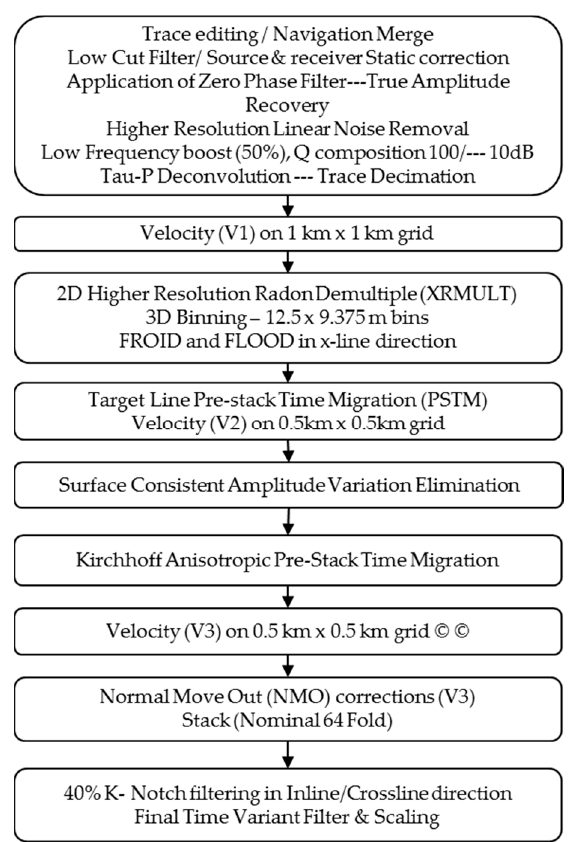
Figure 4. Processing flow chart (adapted from the PETRONAS report).